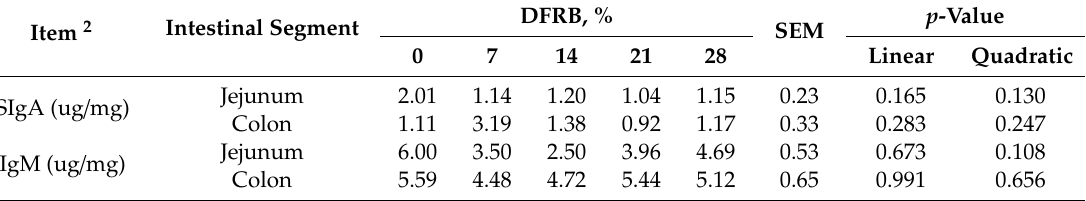
Table 6. E ff ects of increasing DFRB supplementation on SIgA and IgM in jejunum and colon of finishing pigs 1